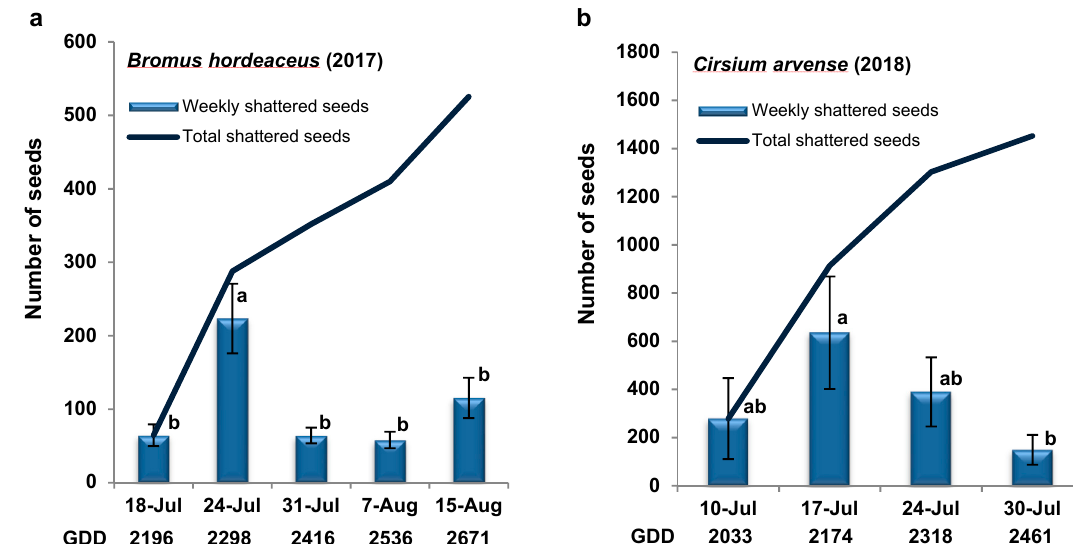
Figure 3. Average weekly and accumulated seed shedding per plant (N = 10) of ( a ) Bromus hordeaceus and ( b ) Cirsium arvense during the growing season of winter wheat. GDD = Growth Degree Days = sum of daily mean temperatures above 0 from the date the winter wheat was sown. Bars show standard deviation. Columns with different letters are statistical significantly different.